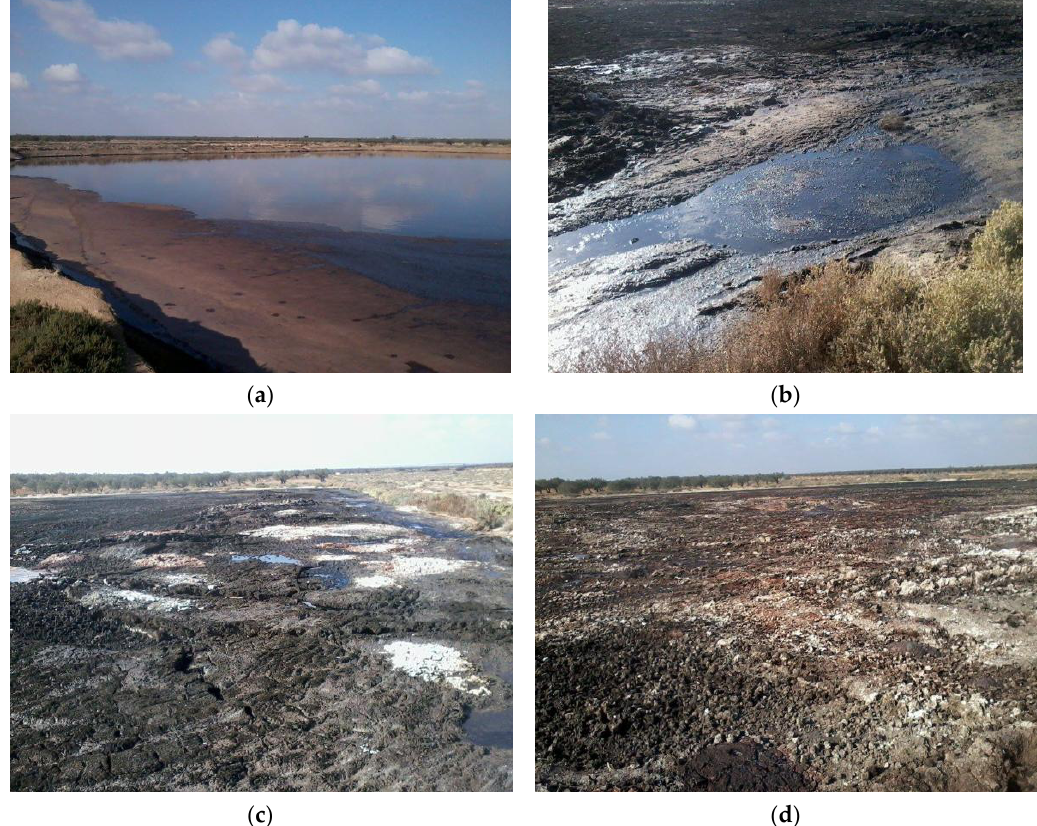
Figure 1. Photos of olive mill wastewaters (OMWW) evolution in deposit basins in the region of Mahdia (Tunisia) at different drying stage. Table 1. Main applied technologies for OMWW treatment.